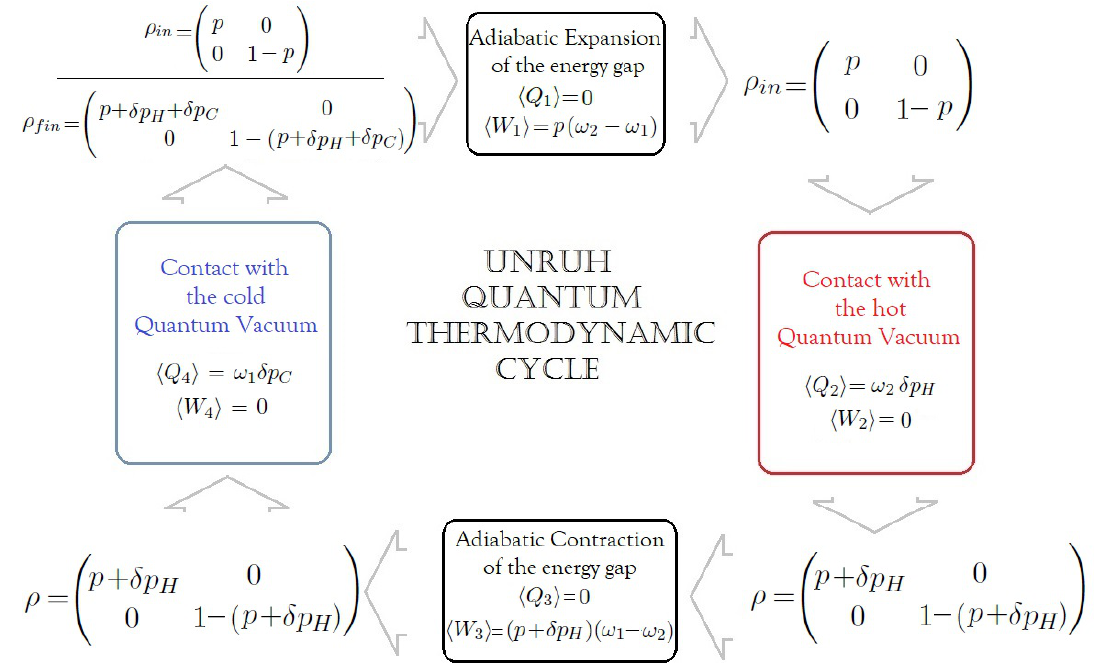
Figure 6. Schematic design of the thermodynamic cycle for the Unruh quantum heat engine. The (cid:12)gure illustrates the di(cid:11)erent states of the qubit, the absorbed heat, and the produced work at each stage of the